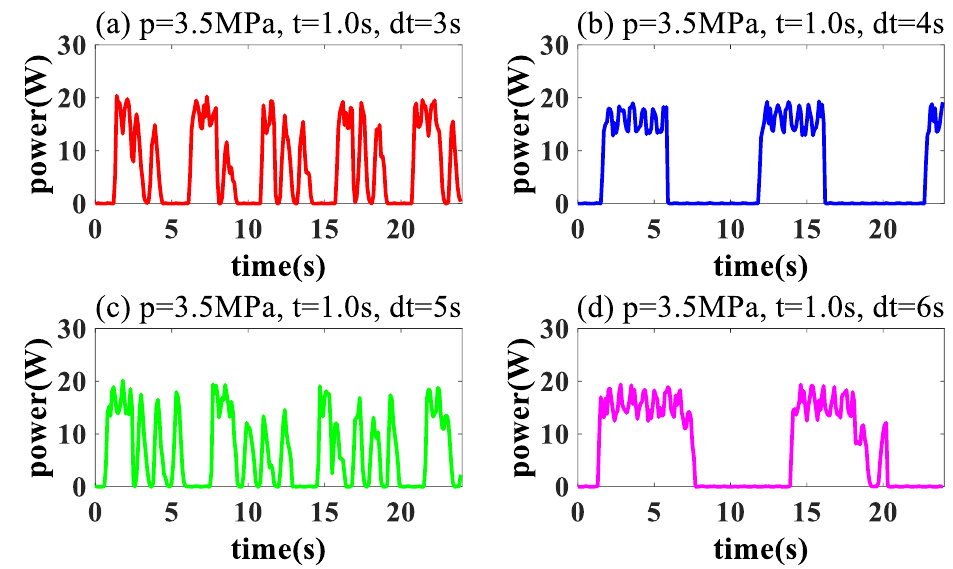
Figure 14. Output power under different open state durations (trigger pressure is 3.5 MPa). The average output power of the electric generator and power fluctuation index un- der different open state durations is shown in Figure 15.